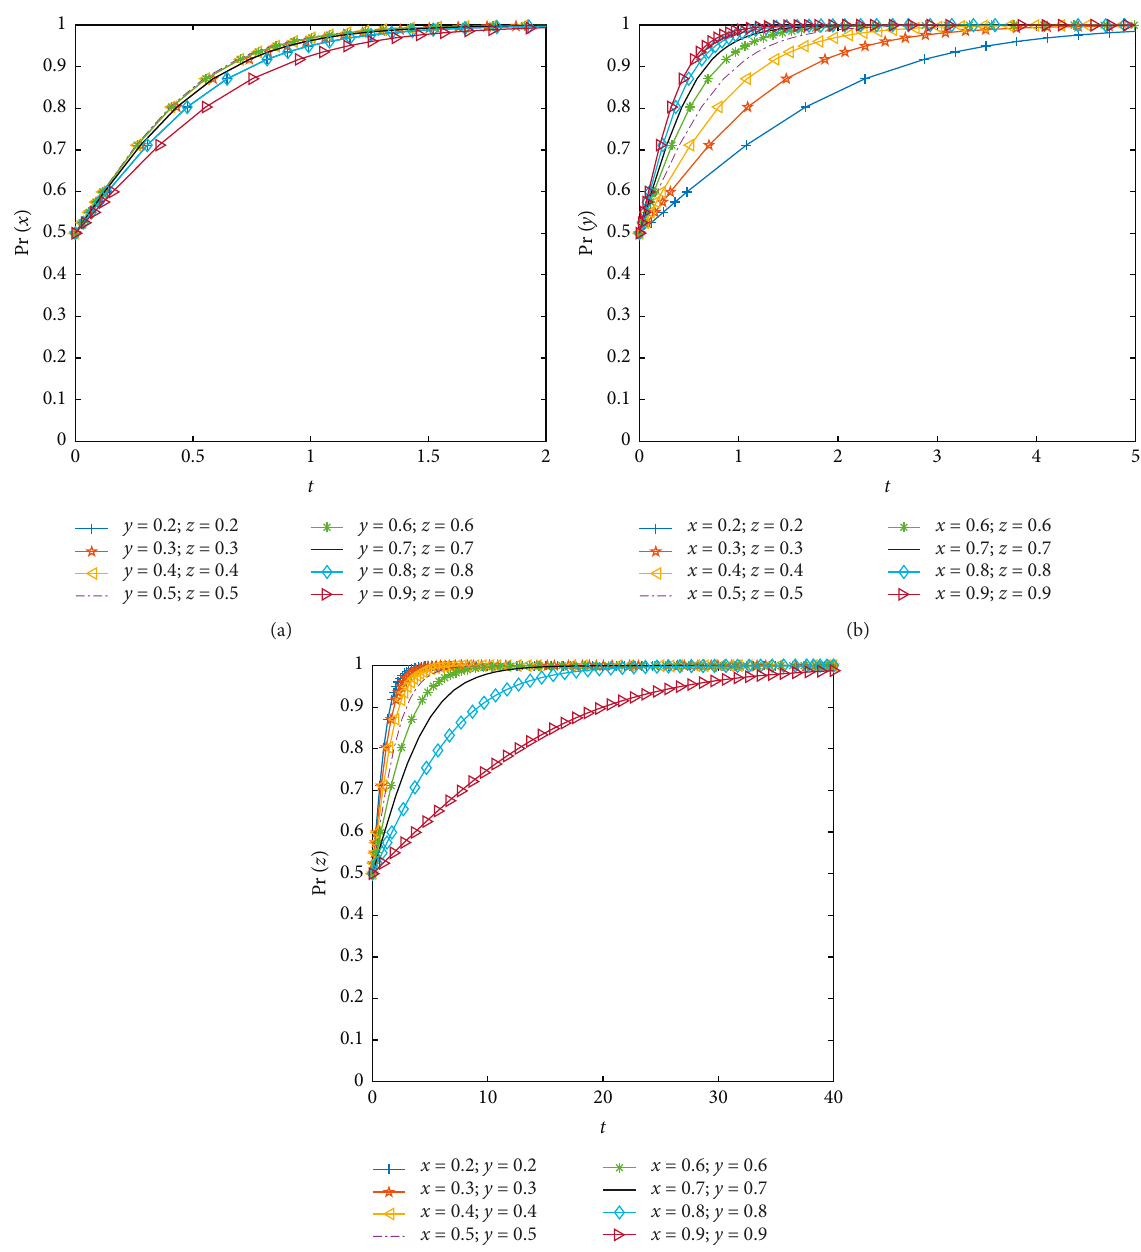
Figure 3: (a) Evolution curve of x when y and z change. (b) Evolution curve of y when x and z change. (c) Evolution curve of z when x and y